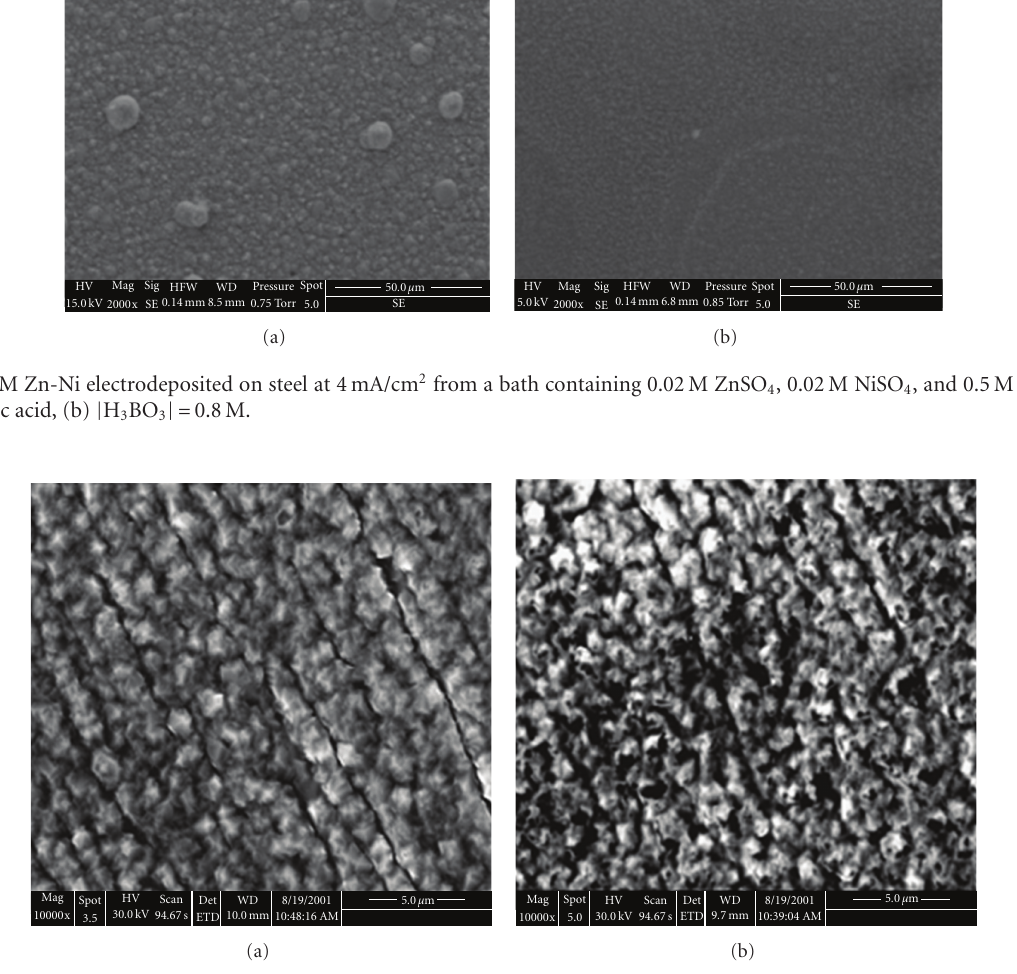
Figure 10: SEM Zn-Ni electrodeposited on steel at 4 mA/cm 2 from a bath containing 0.02 M ZnSO 4 , 0.02 M NiSO 4 , and 0.5 M Na 2 SO 4 . (a) | Cd 2+ | = 0.001 M, (b) | Cd 2+ | = 0.001 M boric acid =